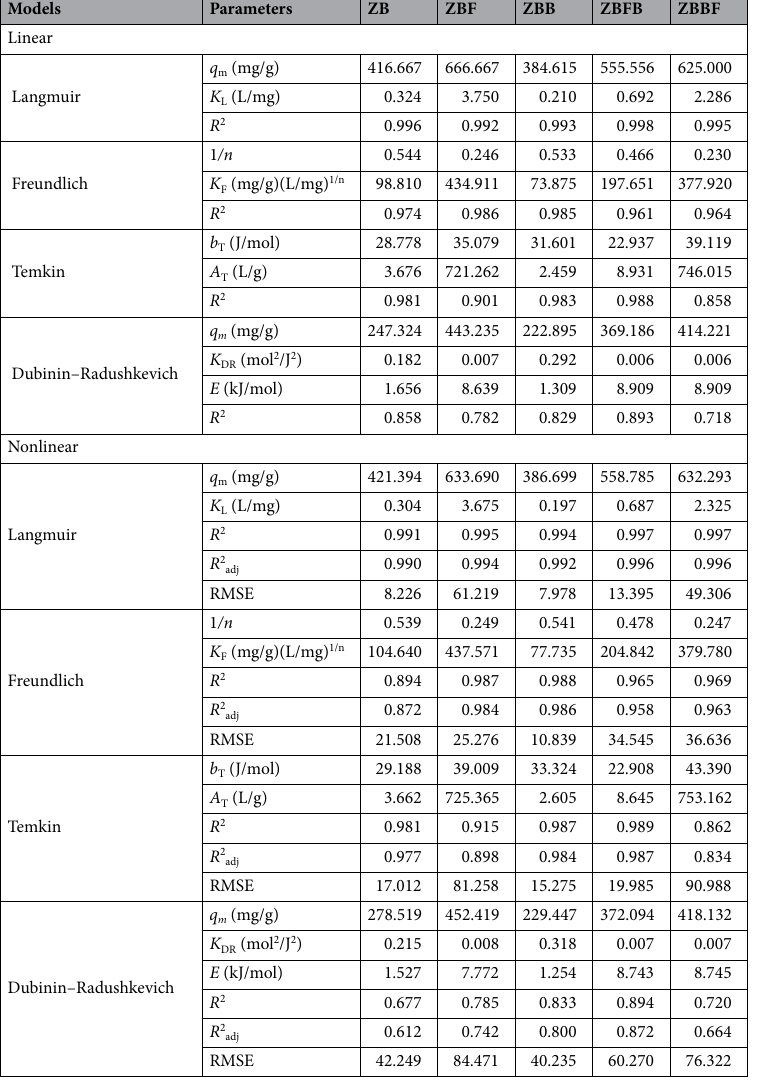
Table 3. The comparison of linear and nonlinear isotherm parameters for lead adsorptions on zeolite A sugarcane bagasse fly ash powder (ZB), zeolite A sugarcane bagasse fly ash powder mixed iron(III) oxide- hydroxide (ZBF), zeolite A sugarcane bagasse fly ash beads (ZBB), zeolite A sugarcane bagasse fly ash powder mixed iron(III) oxide-hydroxide beads (ZBFB), and zeolite A sugarcane bagasse fly ash beads coated iron(III) oxide-hydroxide